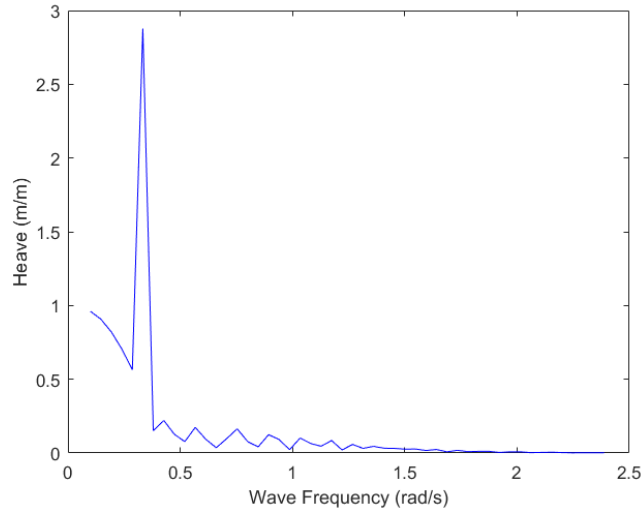
Figure 19. The frequency response of the heave motion of the platform.